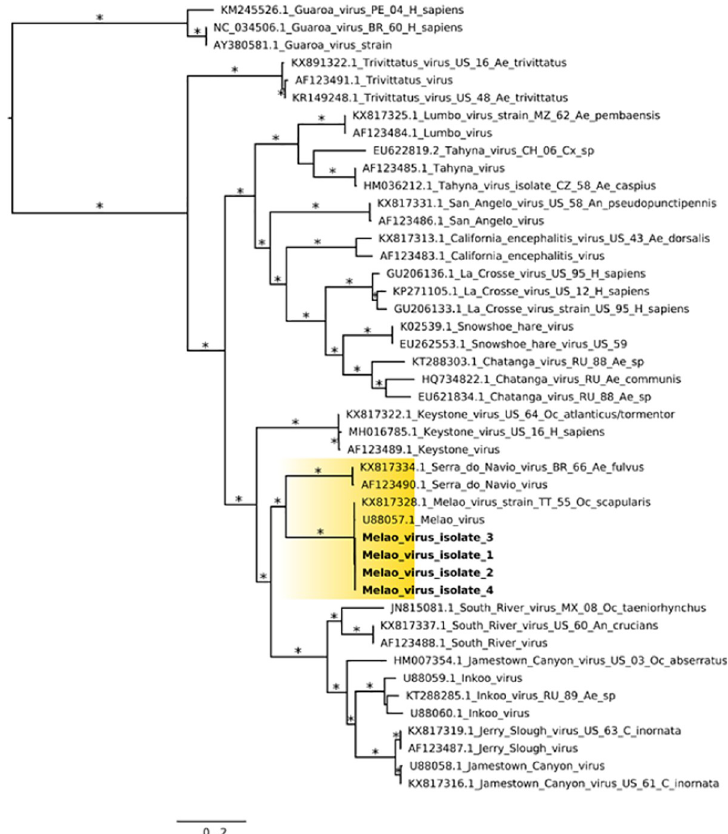
Fig 6. Maximum likelihood tree based on the Large segment of MELV and other California serogroup orthobunyaviruses isolates. MELV isolates from this study are highlighted in yellow color; GenBank accession numbers for the corresponding small genome sequences are: 1 (MN264270); 2 (MN268722), 3 (MN268725), and 4 (MN268728). Branches are labeled with Shimodaira-Hasegawa (SH-like) support values equal or greater than 75%. Branch lengths are drawn in scale of nucleotide substitutions per site according to the bar in the figure. Abbreviations: BR, Brazil; CZ, Czech Republic; FI, Finland; MZ, Mozambique; PE, Peru; RU, Russia; TT, Trinidad and Tobago; US, United States. Mosquito genera: Ae ., Aedes ; An ., Anopheles ; C ., Culiseta ; L ., Lepus; Oc ., Ochlerotatus .